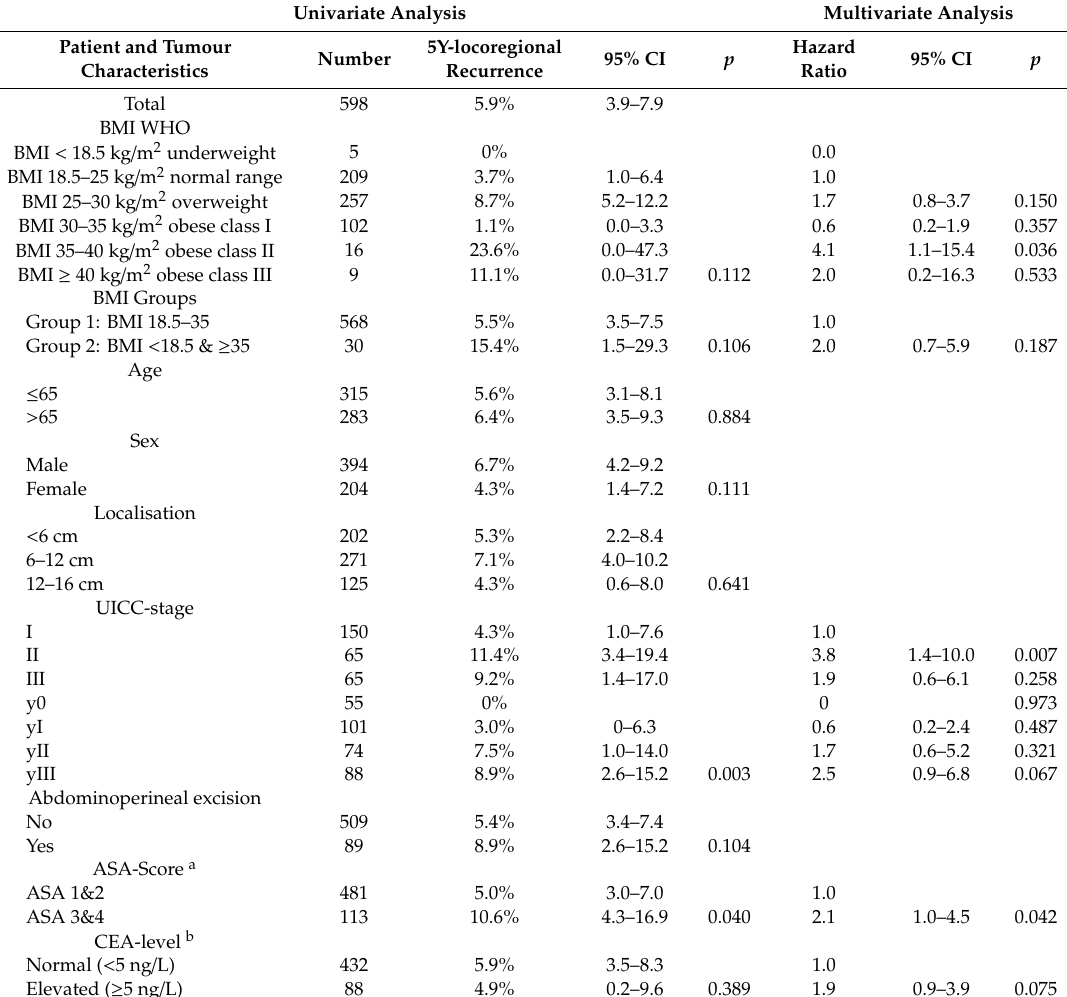
Table 4. 5-year rate of locoregional recurrence for 598 patients. Univariate Analysis Multivariate